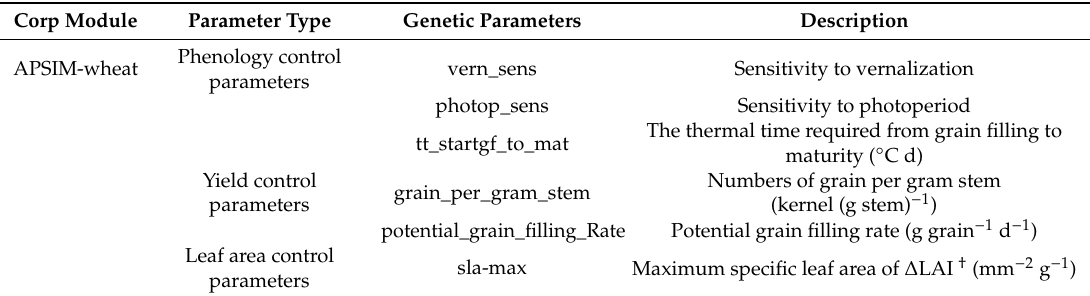
Table 2. Description of genetic coe ffi cients of wheat varieties in the APSIM-wheat